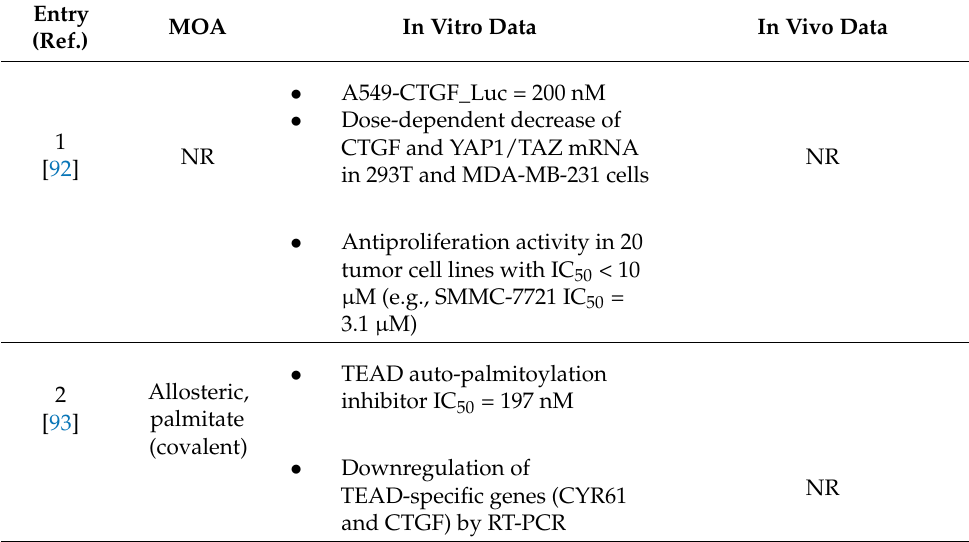
Table 1. Reported key in vitro and in vivo data for each representative example in Figure 3 (MOA = mechanism of action; NR = not